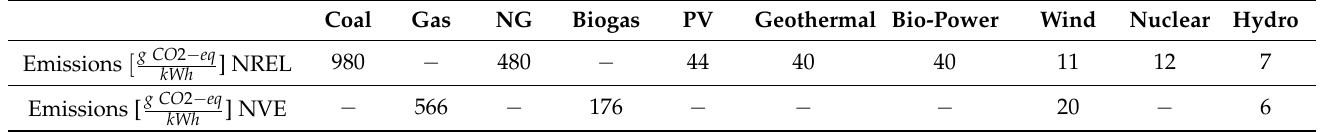
Table 1. GHG emissions from electricity production